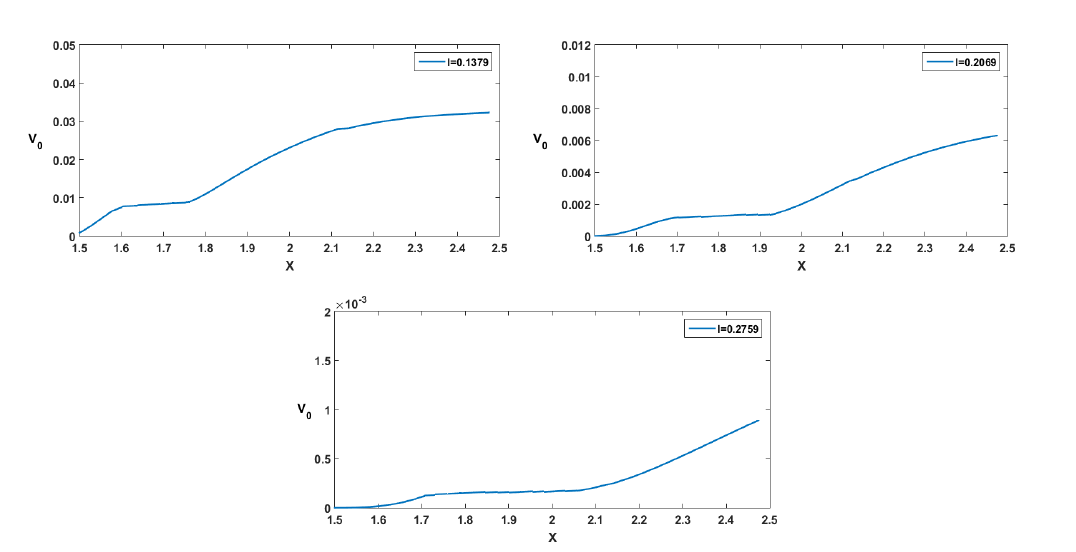
Figure 2. The shape of the value function v sliced in the plane of x for different values of (cid:96) .